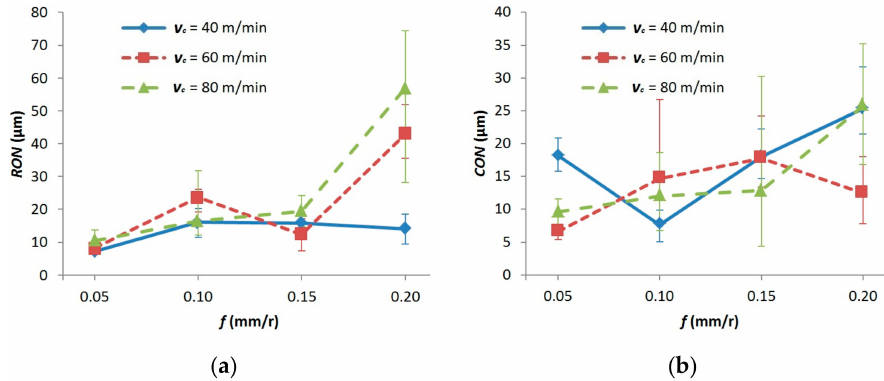
Figure 13. Mean deviations values in function of v c and f for ( a ) roughness and ( b )